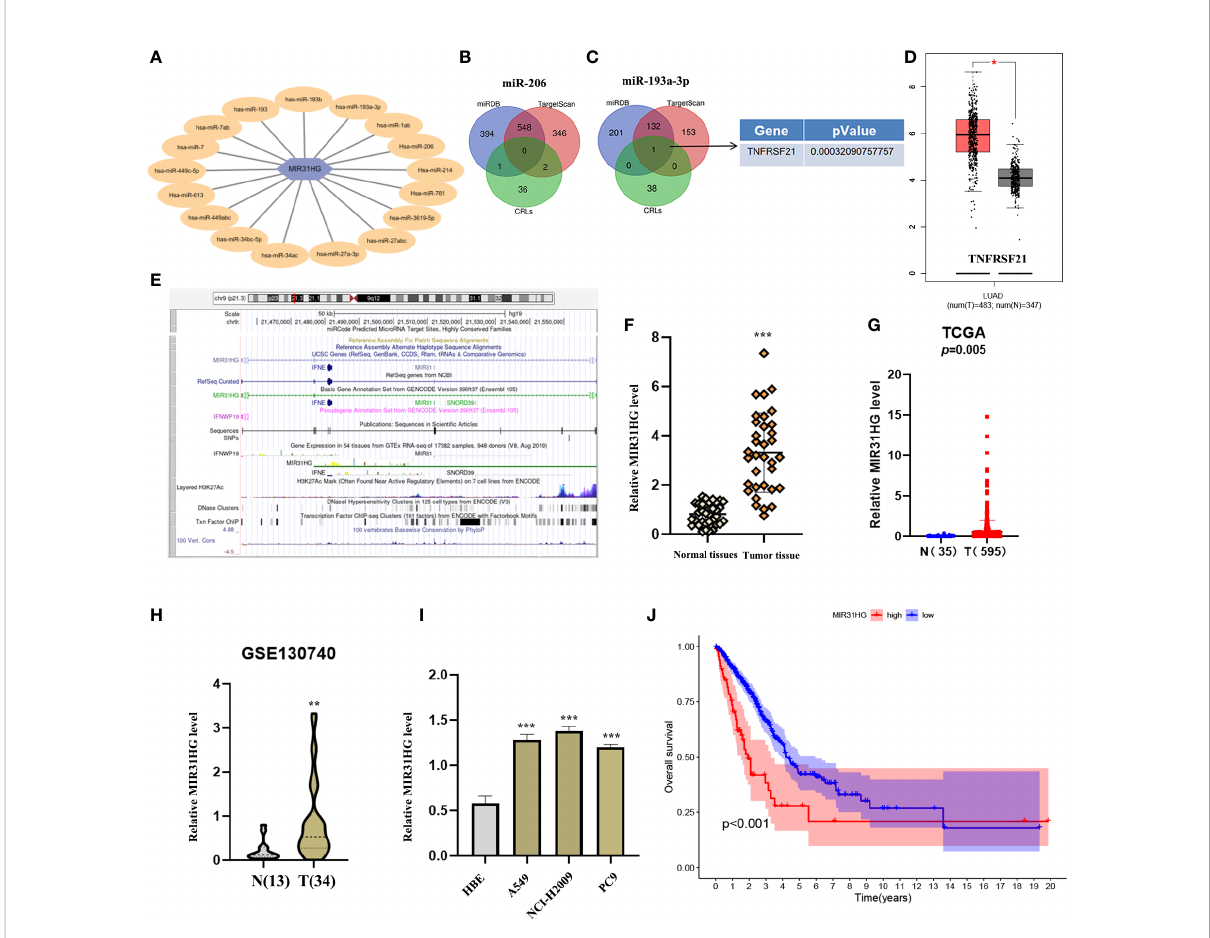
FIGURE 7 Construction of a regulatory axis of lncRNA – miRNA – mRNA. (A) lncRNA MIR31HG bound to 17 miRNAs. (B, C) Venn diagram identifying the downstream targets in miR-206 and miR-193a-3p, respectively, from miRDB and TargetScan databases. (D) The expression of TNFRSF21 was investigated by GEPIA database. (E) Lots of H3K27Ac marks existed in the promoter region of MIR31HG from the UCSC web server. (F, G) MIR31HG expression in lung adenocarcinoma (LUAD) specimens relative to normal tissues as detected by qRT-PCR and The Cancer Genome Atlas cohort. (H) MIR31HG expression in LUAD specimens relative to normal tissues as detected by GSE130740 cohort. ( I ) MIR31HG expression in different LUAD cell lines (A549, NCI-H2009, and PC9) compared with bronchial epithelioid cell (HBE) was estimated by